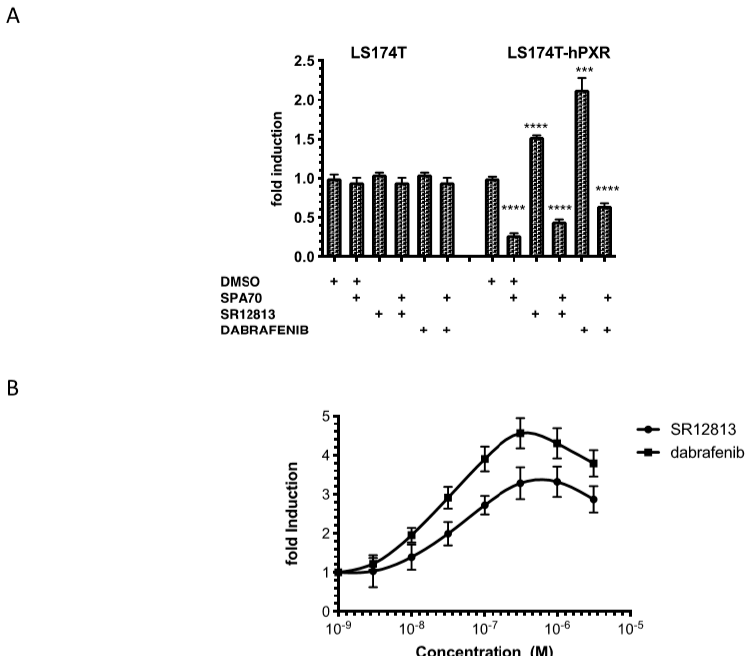
Figure 4. Effects of dabrafenib and SR12813 on the proliferation of LS174T-hPXR cells. ( A ). LS174T control cells and LS174T hPXR cells were treated with 0.1% DMSO, 3 µM SPA70, 0.3 µM SR12813, 0.3 µM SR12813 + 3 µM SPA70, 0.3 µM dabrafenib and 0.3 µM dabrafenib + 3 µM SPA70 for 7 days. ( B ) LS174T hPXR cells were pretreated 24 h with SPA70 100 nM. This pretreatment was performed